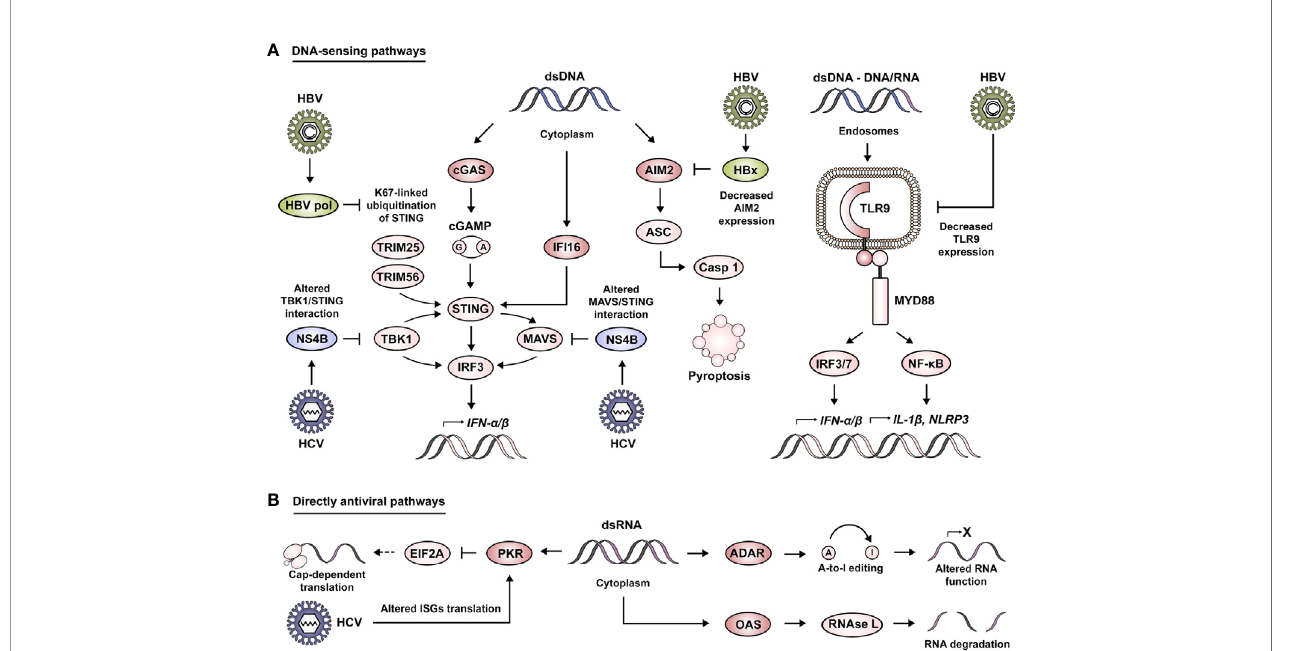
FIGURE 2 | Viral manipulation of DNA-sensing and directly antiviral signaling pathways. (A) Foreign DNA sensing is mediated by cGAS, IFI16 and AIM2 in the cytoplasmic compartment. cGAS activation leads to the production of cGAMP, which acts as a second messenger to induce STING activation. cGAMP binding to STING induces its dimerization and K63 ubiquitination by TRIM25 and TRIM56. This leads STING to interact with TBK1 and transduce these signals via IRF3 or MAVS in order to produce type I IFNs. Moreover, STING can also be activated by IFI16. AIM2 sensing of cytosolic DNA results in its interaction with ASC, leading to the cleavage of caspase 1, the secretion of IL-1 b and the induction of pyroptotic cell death. Foreign DNA sensing is mediated by TLR9 in the endosomal compartment. These signals are transduced by intermediary of MYD88 and IRF3/7 in order to produce type I IFNs, and to the expression of other genes such as IL- 1 b and NLRP3 via the NF- k B pathway. HBV has been described to impair DNA-sensing pathways via HBV pol-mediated alteration of K67-linked ubiquitination of STING, HBx-mediated degradation of AIM2 and the decrease of TLR9 expression. Similarly, HCV affects DNA sensing by altering TBK1/STING and MAVS/STING interaction via its viral protein NS4B. (B) Directly antiviral pathways are mediated by the action of PKR, ADAR, and OAS. PKR activation leads to the inhibition of mRNA translation via interference with EIF2A. HCV has been described to exploit PKR activity as a means to alter the translation of ISGs. OAS proteins lead to the activation of RNase L and the induction of RNA degradation. ADAR proteins mediate A-to-I editing, leading to the alteration of RNA structure, localization and coding